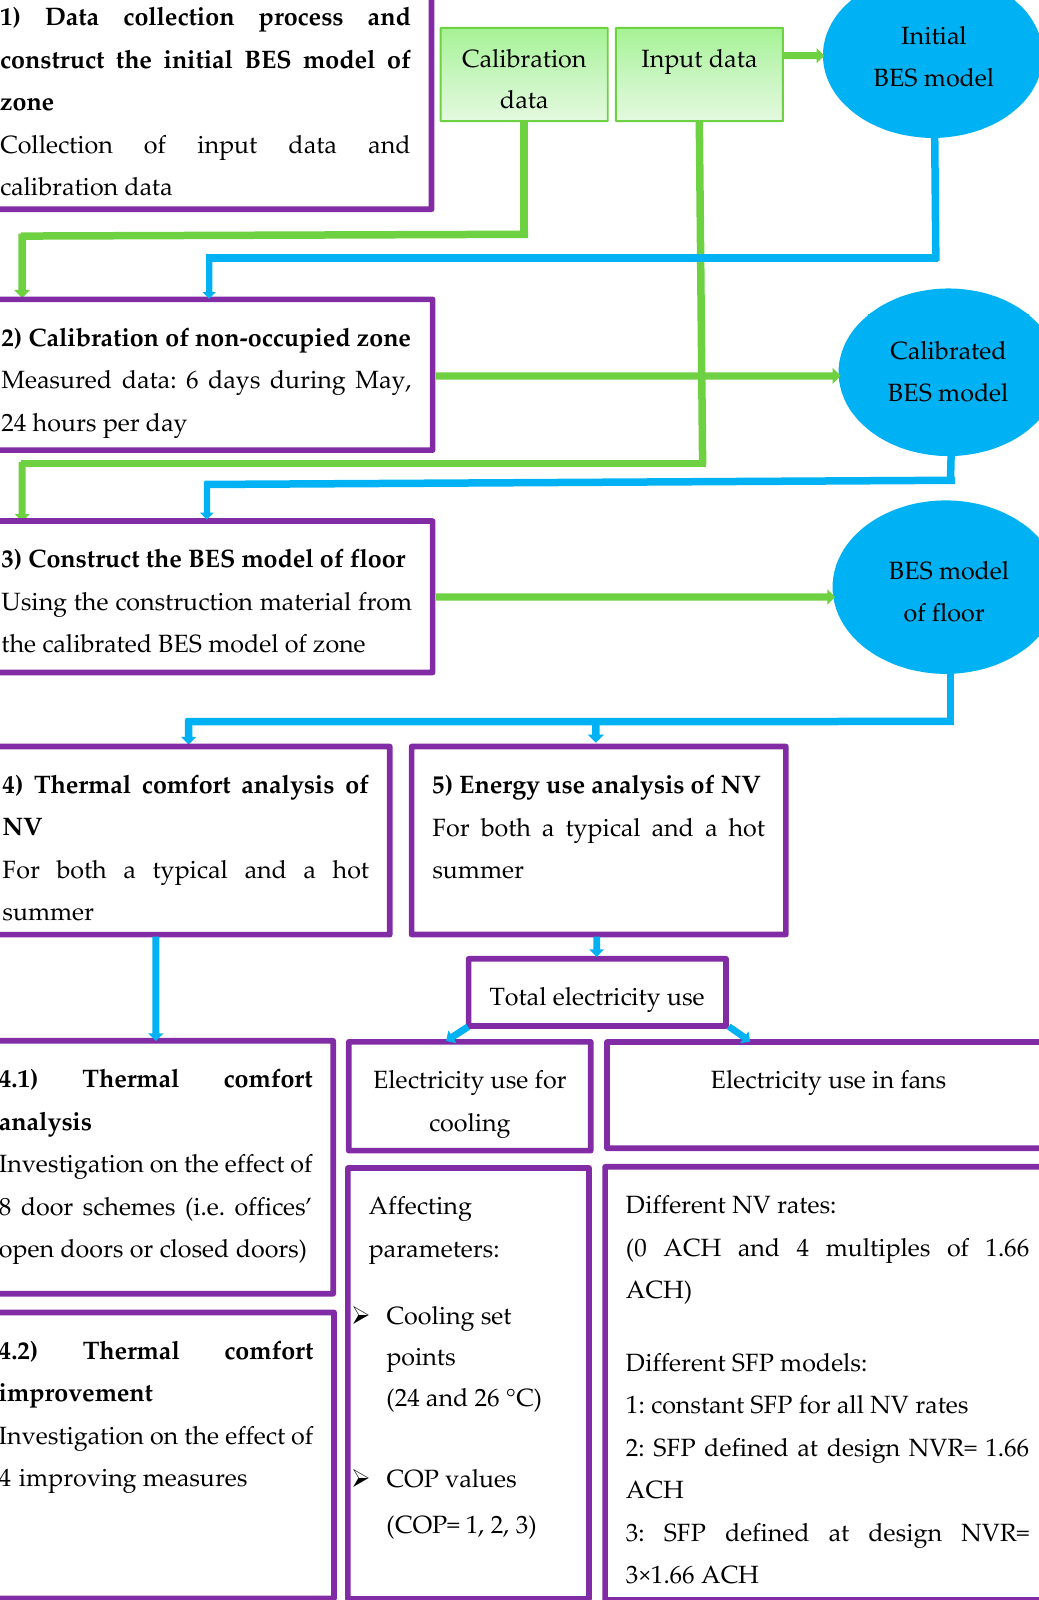
Figure 2. Overview of the research process .